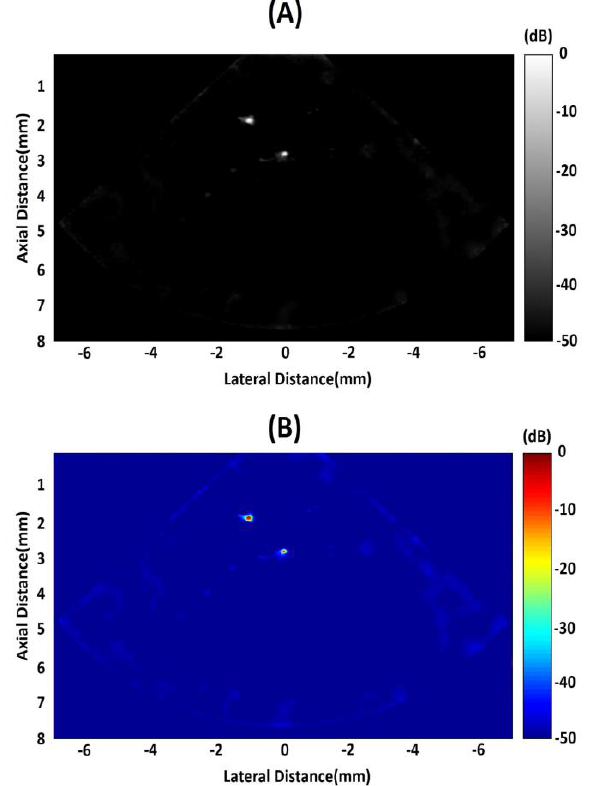
Figure 9. ( A ) Acquired image of custom-made fine-wire phantom. ( B ) Pseudo-color image of custom-made fine-wire phantom.